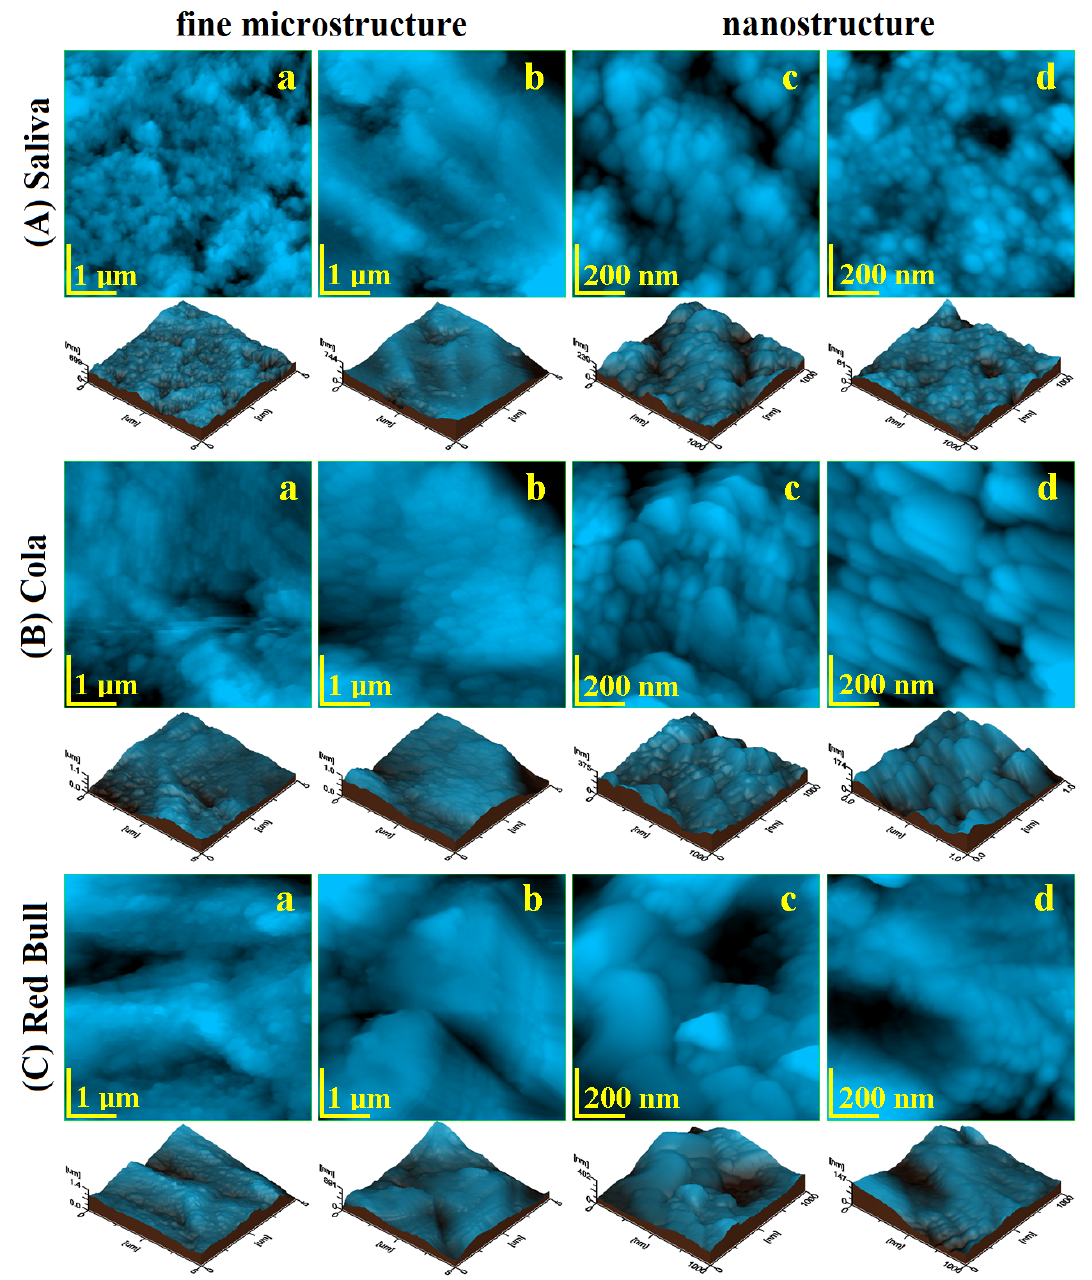
Figure 3. AFM imaging of enamel after CR debonding: fine microstructure before polishing ( a ) and after polishing ( b ); nanostructure before polishing ( c ) and after polishing ( d ); stored in Saliva ( A ), exposed to Cola ( B ), and exposed to Red Bull TM ( C ).